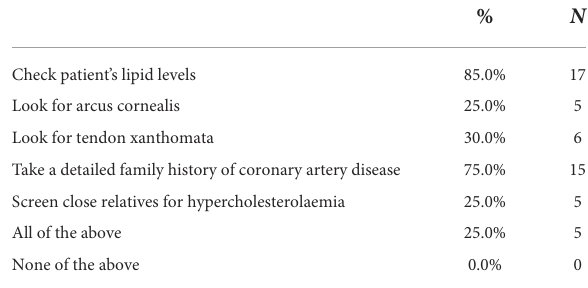
TABLE 3 Routine care activities used for patients with documented premature CAD.